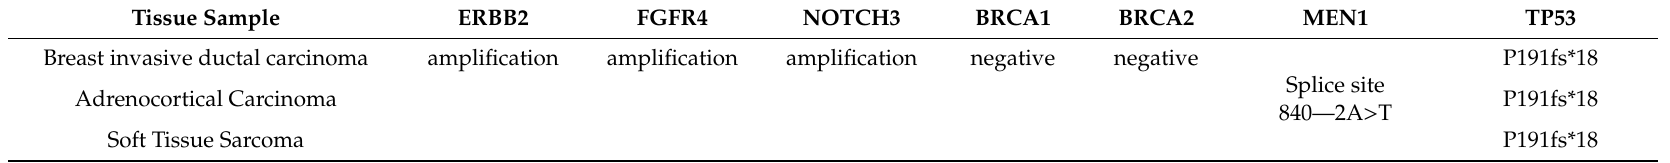
Table 1. FoundationONE CDx results of next generation sequencing results from respective tumour tissue samples.